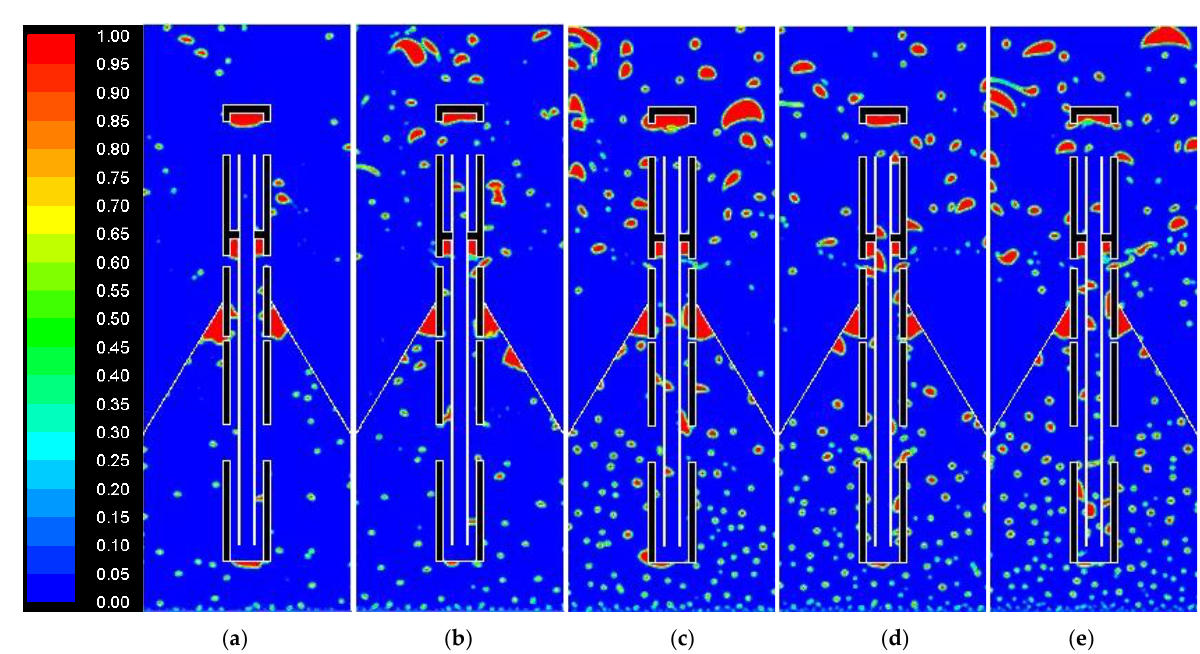
Figure 5. Cloud diagram of gas-phase distribution at gas holdup 10% when total flow is at ( a ) 20 m 3 /d; ( b ) 30 m 3 /d; ( c ) 40 m 3 /d; ( d ) 50 m 3 /d; ( e ) 60 m 3 /d